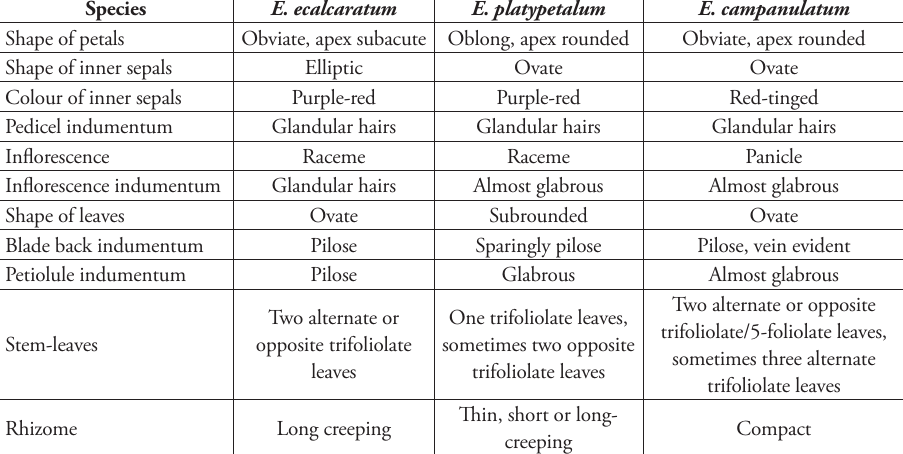
Table 3. The main discrete morphological characters comparative analysis of populations of E. ecalcaratum , E. platypetalum , and E. campanulatum .